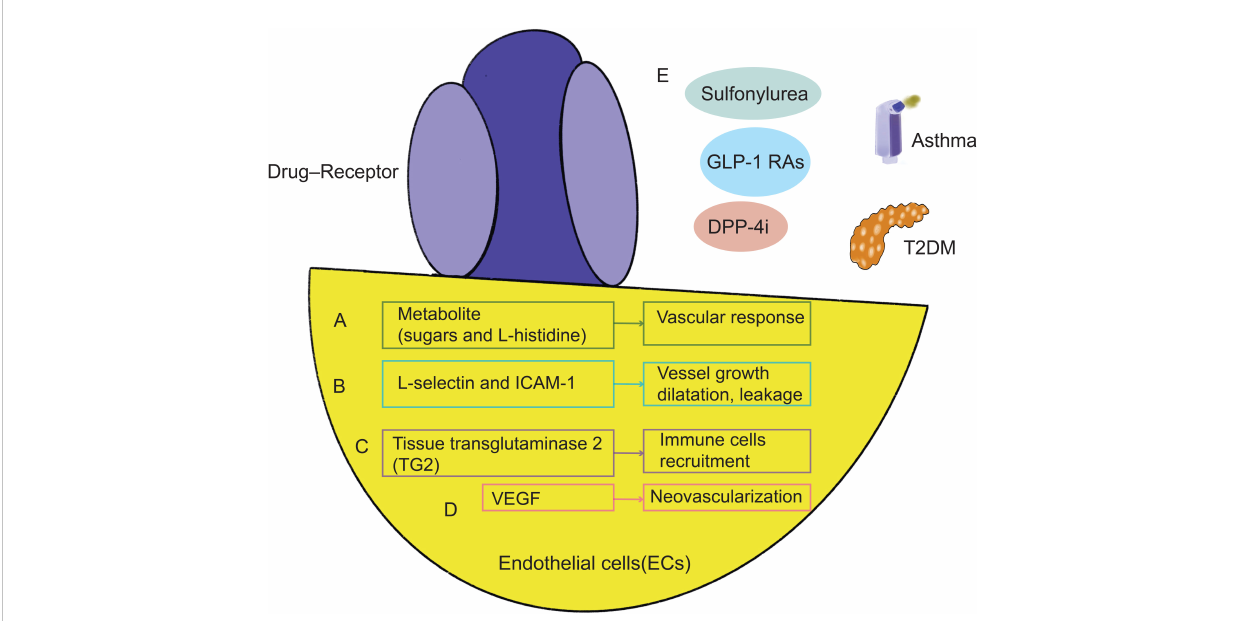
FIGURE 4 Mechanisms shared by asthma and T2DM in endothelial cells. Metabolite (A) , L-selectin, ICAM-1 (B) , tissue transglutaminase 2 (TG2) (C) , and VEGF (D) are all intimately connected to and have an impact on each other in endothelial cells, which may represent a common mechanism of lung function decline. GLP-1 RAs targeting endothelial cells, DPP-4i and other drugs can treat asthma and diabetes (E) . GLP-1 RAs, GLP-1 receptor agonists; DPP-4i, Dipeptidyl peptidase 4 inhibitors; VEGF, Vascular endothelial growth factor; ICAM-1, Adhesion molecule